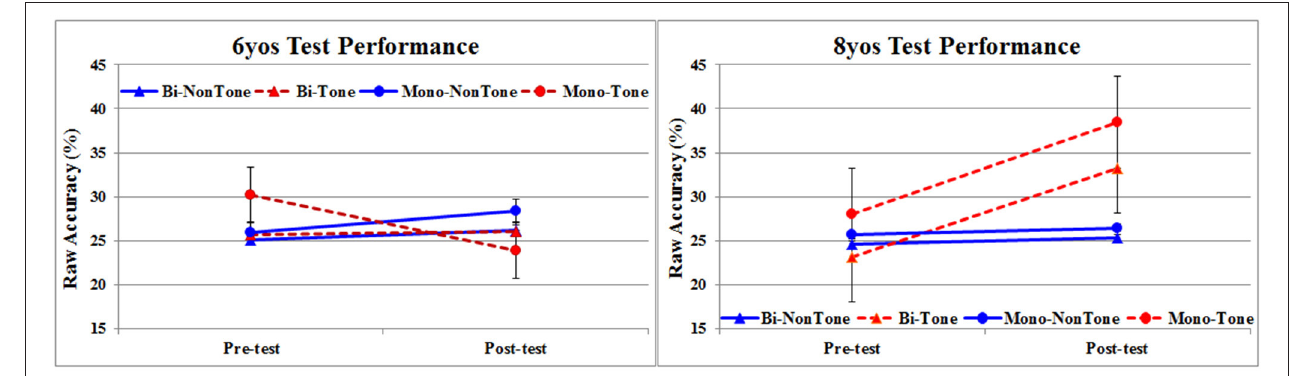
FIGURE 3 | Mean percentage of Pre- to Post-training improvement gain by each of the four language groups at 6 and 8 years, with AO or AV Training ao and av Test Types. Error bars represent standard errors.